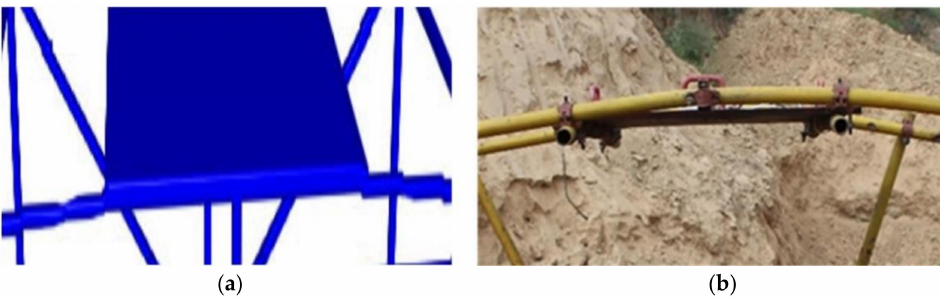
Figure 17. Comparison of numerical and test data of damage details. ( a ) Numerical results; ( b ) Test